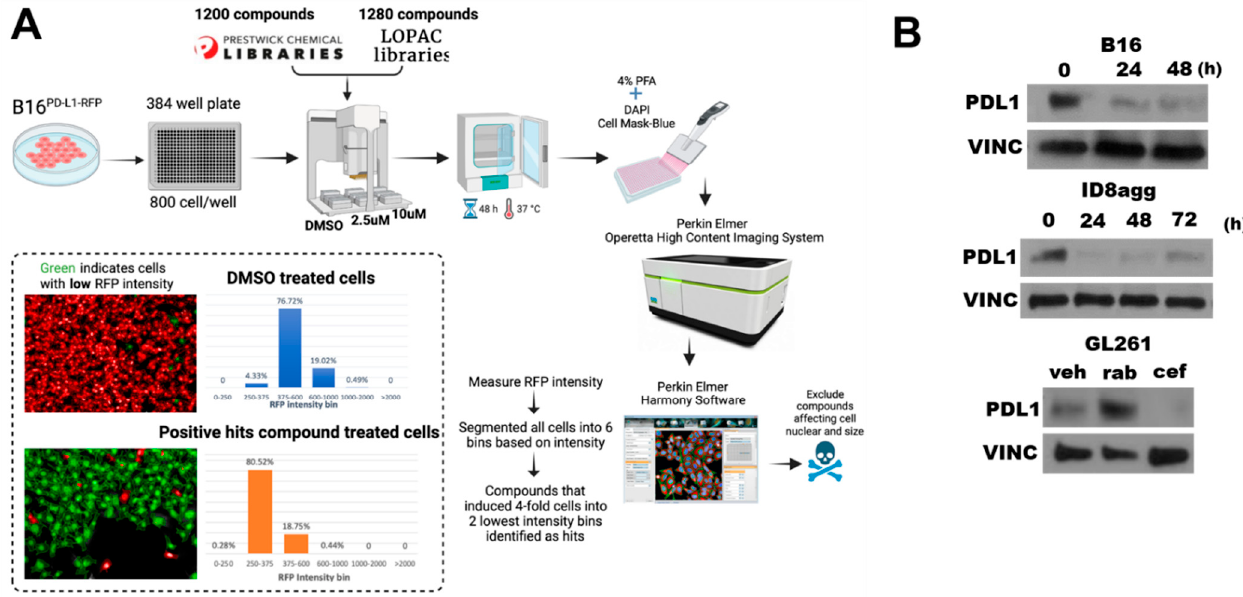
Figure 1. Cefepime depletes tumor PDL1 in multiple distinct tumor cell lines. ( A ) Schematic of high-throughput drug screen used to identify pharmacologic PDL1-depleting agents (PDDs). ( B ) Immunoblots of PDL1 and the loading control vinculin (VINC) in B16, ID8agg, and GL261 cells treated with 80 μ M cefepime for indicated times. GL261 cells were treated with DMSO (veh), 250 nM rabusertib (rab), or 80 μ M cefepime (cef) for 48 h. Cefepime was replenished daily.